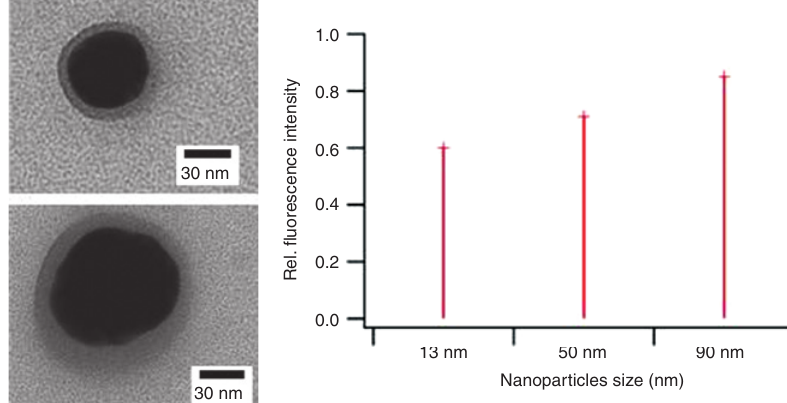
Figure 15: Left: TEM pictures of the polymer functionalized nanoparticles 50–90 nm. Right: Fluorescence intensity of the hybrid